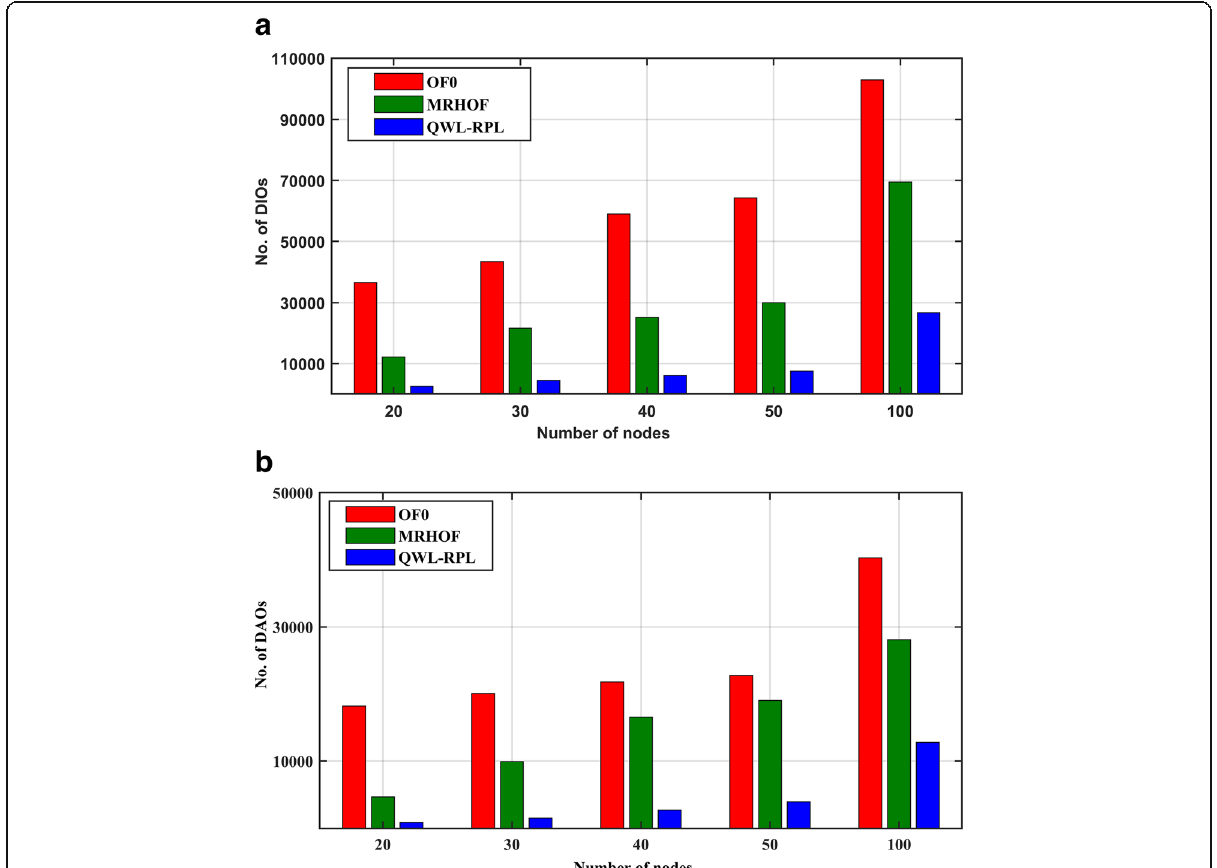
Fig. 12 Simulation analysis for scenario II for the a total number of DIO overheads and b total number of DAOs versus number of